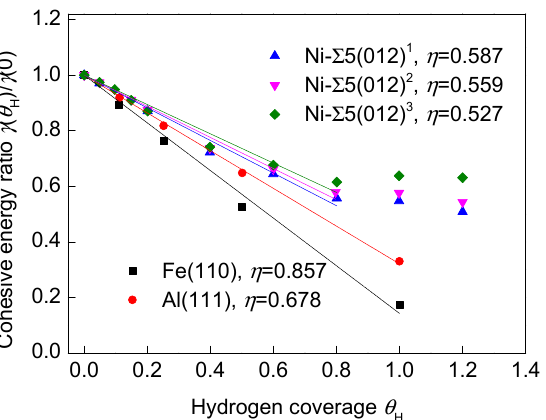
Figure 1. Effect of hydrogen coverage on cohesive energy of Fe(110), Al(111) crystal interface [34] and Ni- ∑ 5(012) grain boundary [35] (Ni- ∑ 5(012) grain boundary has three sets of data due to different calculation schemes used by the authors).